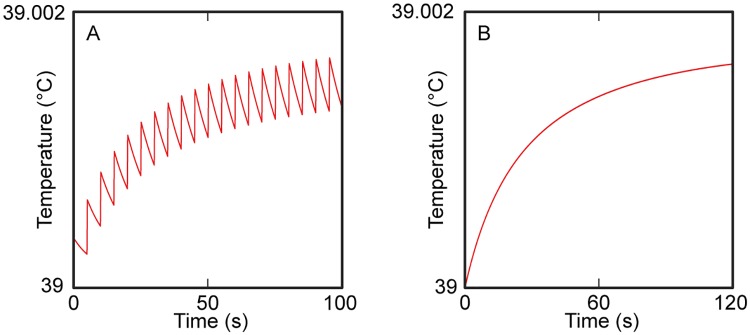
Estimated temperature rise at the focus.(A) 20 sonication repetitions with 5 s ISI using excitatory parameter set of EP30. (B) Sonication duration of 2 min using suppressive parameter set of SP6. The trace of thermal change was illustrated with the raw data of numerical simulation performed with a temporal resolution of 0.2 ms.